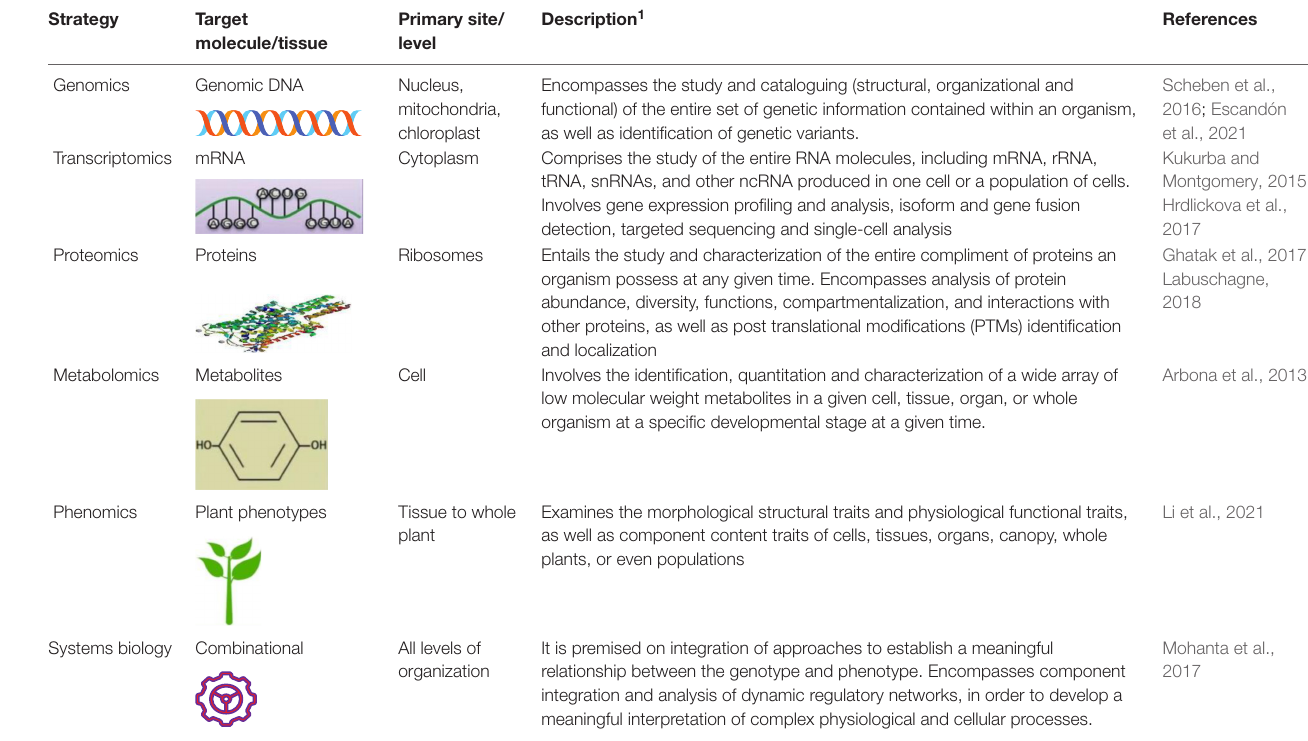
TABLE 1 | An overview of main omics strategies for crop